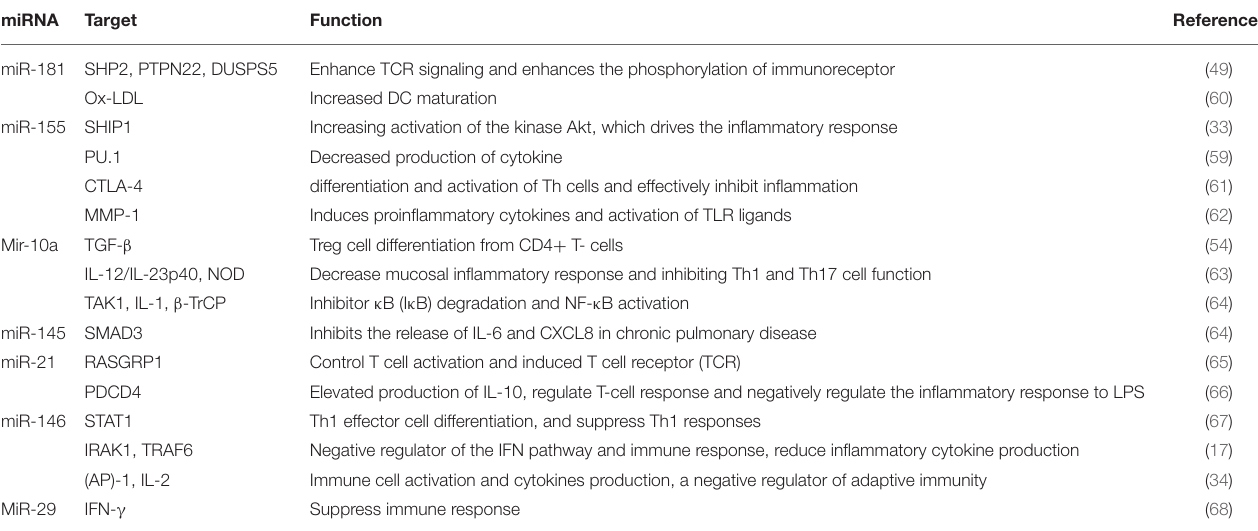
TABLE 1 | miRNAs Involved in the Development and Function of the Immune System.